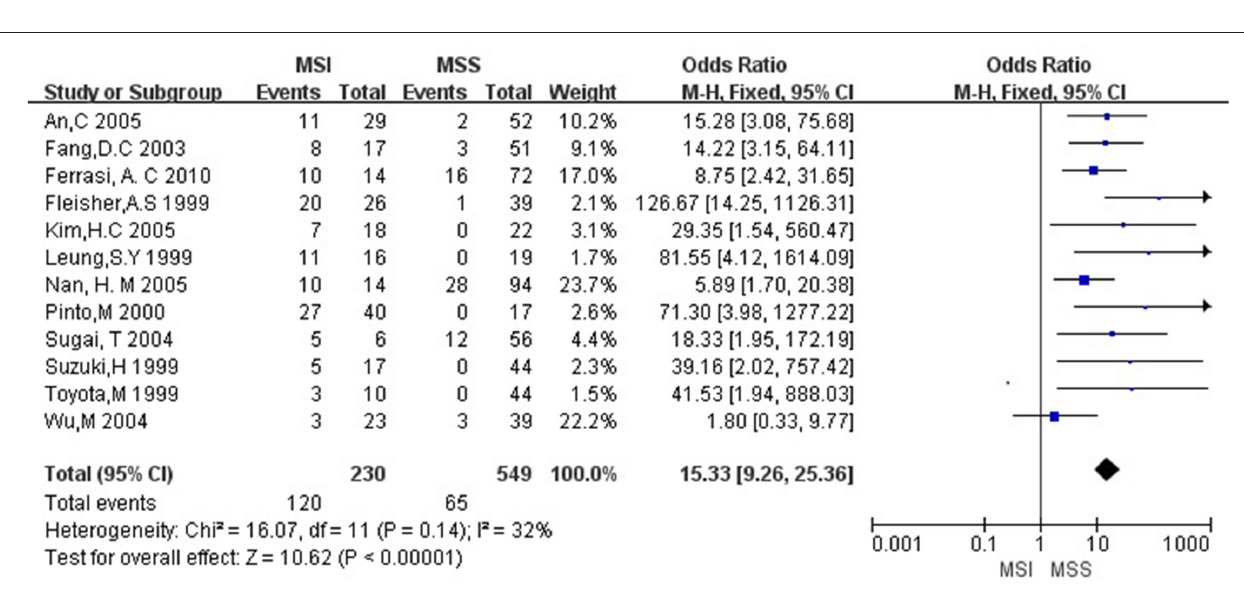
FIGURE 4 | Forest plot concerning hMLH1 methylation and MSI. MSI, microsatellite instability. Fixed-effect model was used.